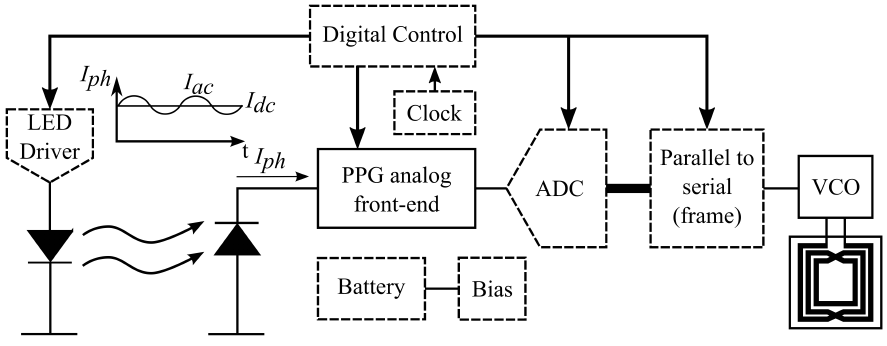
Figure 1. Block diagram of the subcutaneous PPG system where the blocks in solid boxes have been integrated using the ON Semiconductor 0.5-µm CMOS process and the blocks in dashed boxes have been implemented with smaller COTS components.